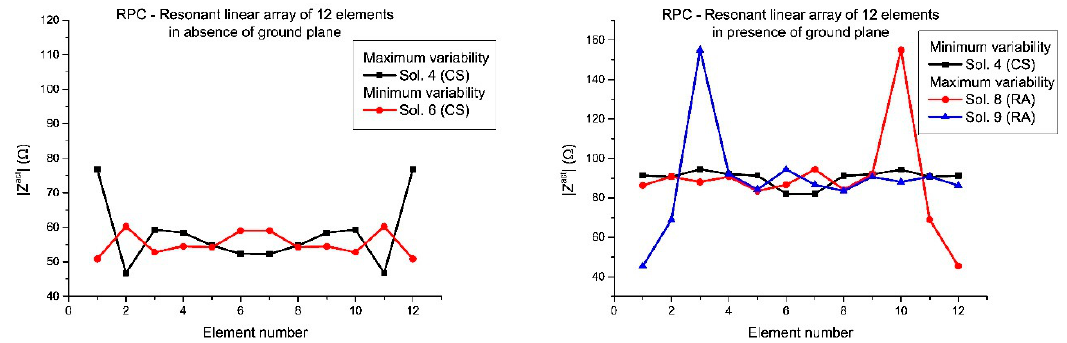
Figure 9. Detailed view of the active impedances which present the maximum and the minimum variability from the set of solutions for the RPC, in the case of the resonant linear array of 12 elements: in absence of ground plane ( left ) and in presence of ground plane ( right ). The numbering of the solution agrees with Figure 1.